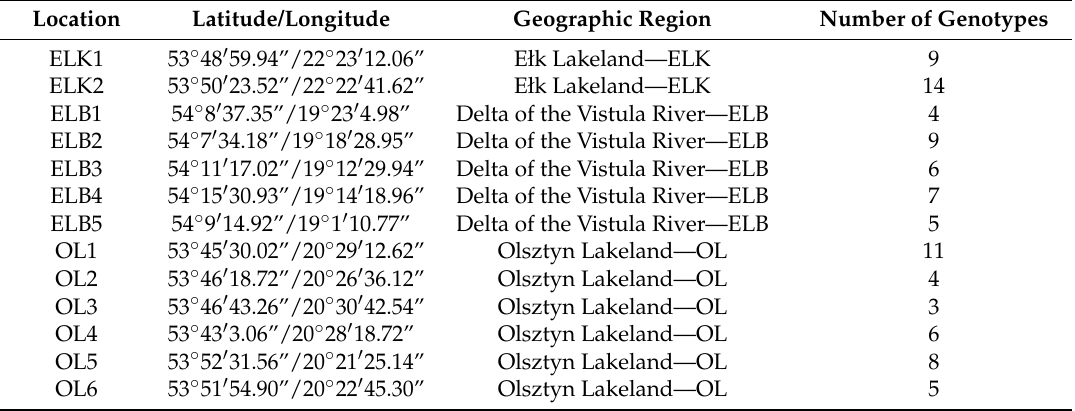
Table 6. Geographic information relating to the analyzed natural locations of S. purpurea